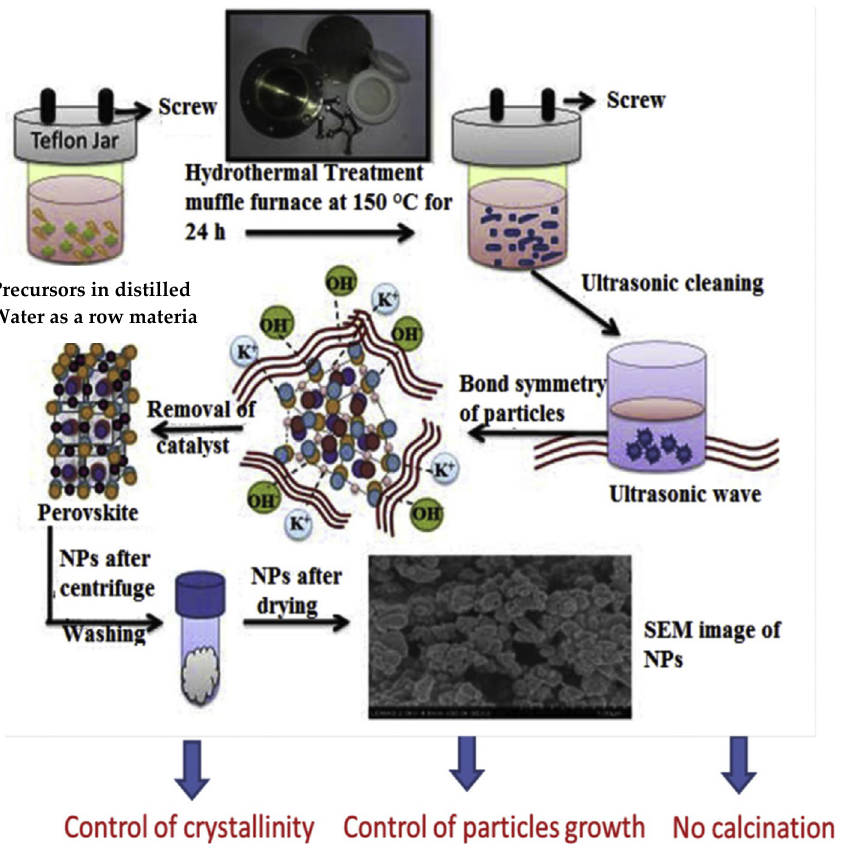
Figure 23. Scheme for the synthesis of perovskite using the hydrothermal process (Reprinted with permission from